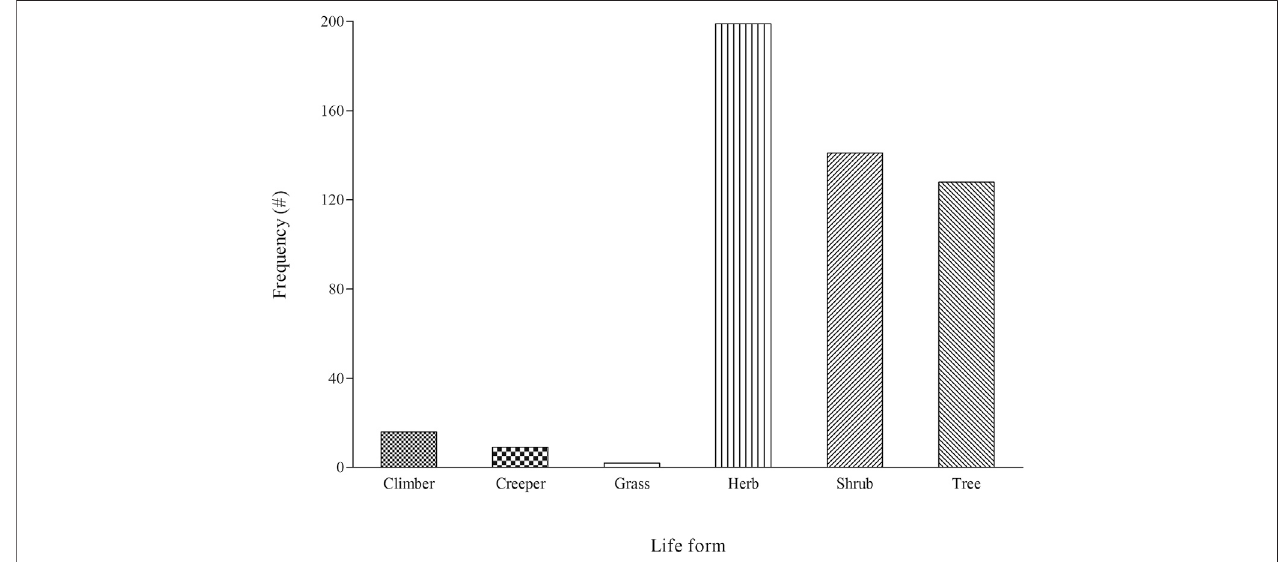
FIGURE4| Anoverviewoflife-formforplantsindicatedasaremedyforpainandin fl ammatory-relatedconditionsamongdifferentethnicgroupsinSouthAfrica,# (cid:1) number of mentions.